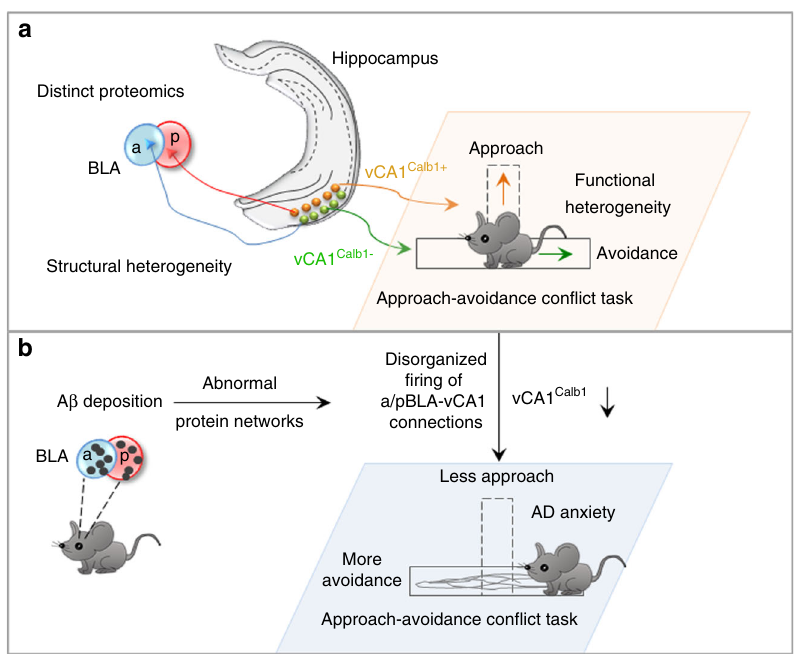
Fig. 7 Proposed working model. a Heterogeneity in the BLA – vCA1 circuit under physiological conditions. The BLA shows proteomic diversity along its anterior – posterior axis at the molecular level. The anterior part of the BLA (aBLA) and the posterior BLA (pBLA) innervate the deep-layer calbindin1- negative neurons (Calb1 − ) and super fi cial-layer calbindin1-positive neurons (Calb1 + ) in vCA1, forming aBLA – vCA1 and pBLA – vCA1 circuits, respectively. This molecular and structural heterogeneity endows these pathways with functional heterogeneity in controlling approach - avoidance behaviour, i.e., the aBLA – vCA1 Calb1 − circuit promotes avoidance and exerts an anxiogenic effect, while the pBLA – vCA1 Calb1 + circuit triggers approach and exerts an anxiolytic effect. b In AD, different protein network changes in response to A β deposition in the aBLA and pBLA impair the aBLA – vCA1 Calb1 − and pBLA – vCA1 Calb1 + circuits. Together with their disorganised fi ring patterns, the AD mice prefer avoidance over approach in con fl ict tasks and display anxiety. Furthermore, Calb1 expression determines the anxiolytic effect of pBLA – vCA1 Calb1 + stimulation in AD, indicating a molecular mechanism at the exit node of the pBLA – vCA1 Calb1 +